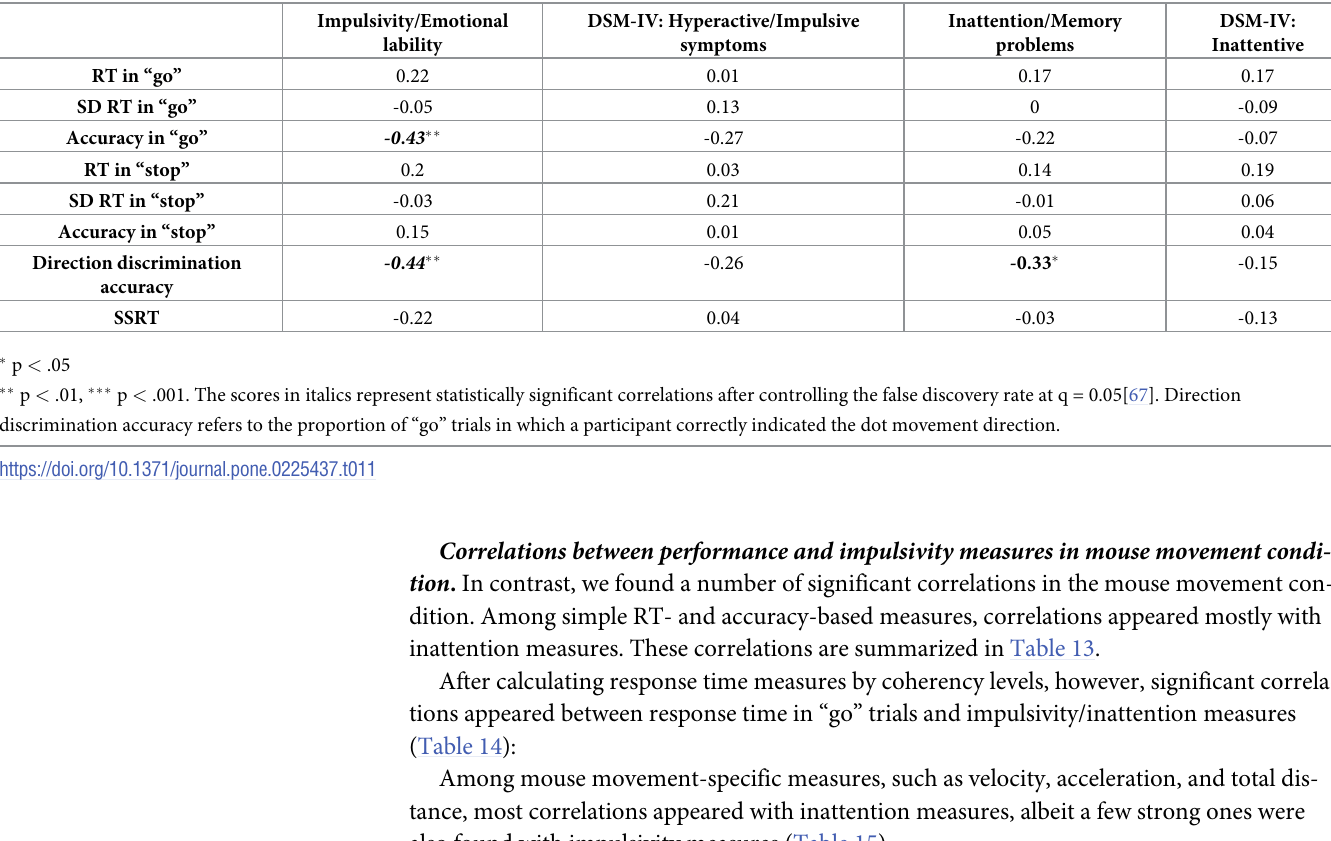
Table 11. Values of Spearman’s ρ for correlations between keypress measures and impulsivity/inattention measures. Impulsivity/Emotional lability